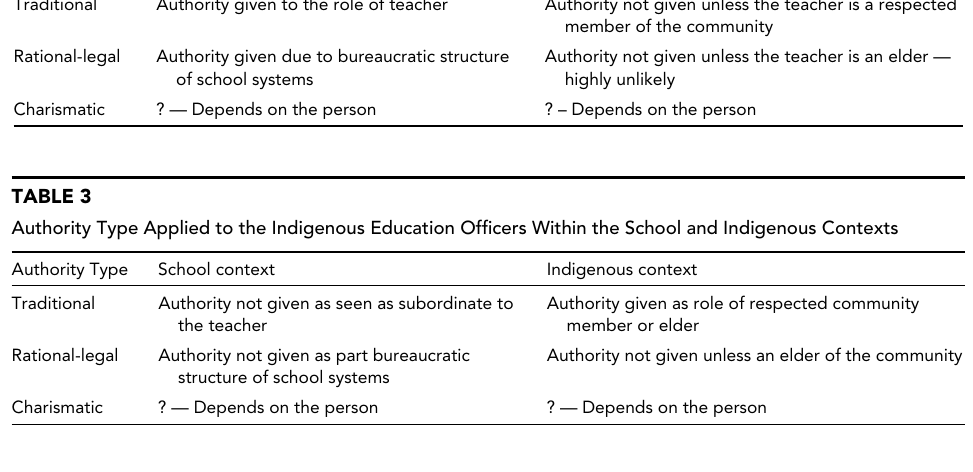
Authority Type Applied to the non-Indigenous Teachers Within the School and Indigenous Contexts Authority type